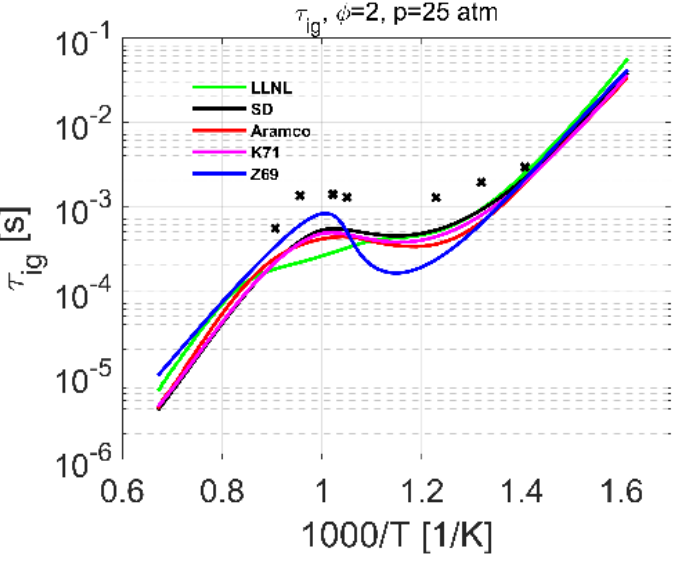
Figure A1. Ignition delay time for DME-air mixtures at 25 atm and ϕ = 2.0. Legend: experimental data for τ ig from (×) Burke et al. [17]. Mechanism predictions from Z69 in blue, LLNL in green [28],